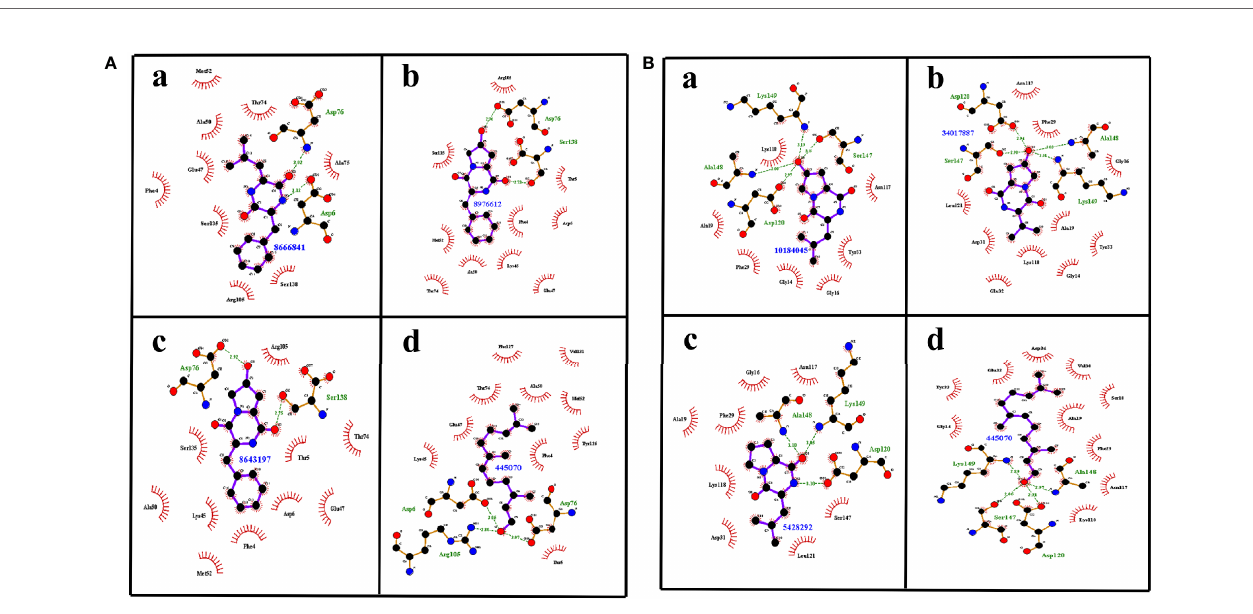
FIGURE 2 | (A) The two-dimensional interaction image showcasing the binding pattern of selected top three ligands such as QSSM 1157 (a), QSSM 1141 (b), and QSSM 1153 (c) and the positive control farnesol (d) against CYCc. (B) The two-dimensional interaction pattern of selected top three ligands such as QSSM 1151 (a), QSSM 1148 (b), and QSSM 1112 (c) and the positive control farnesol (d) against